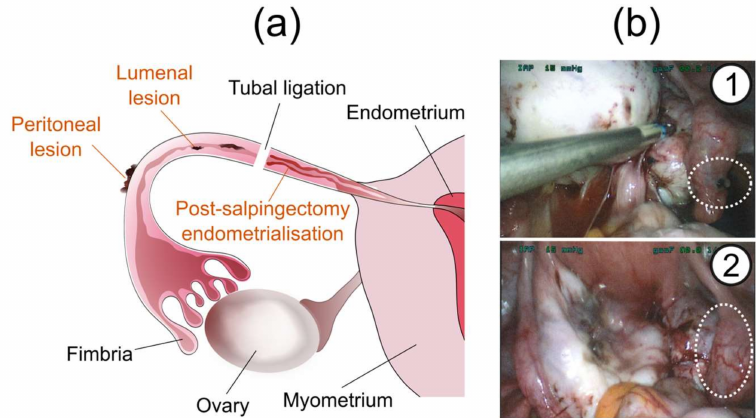
Figure 2. Tubal endometriosis. ( a ) Manifestations of tubal endometriosis. ( b ) Peritoneal endometriotic lesion on the tubal serosa ( 1 ) and hydrosalpinx resulting from endometriosis-induced tubal occlusion ( 2